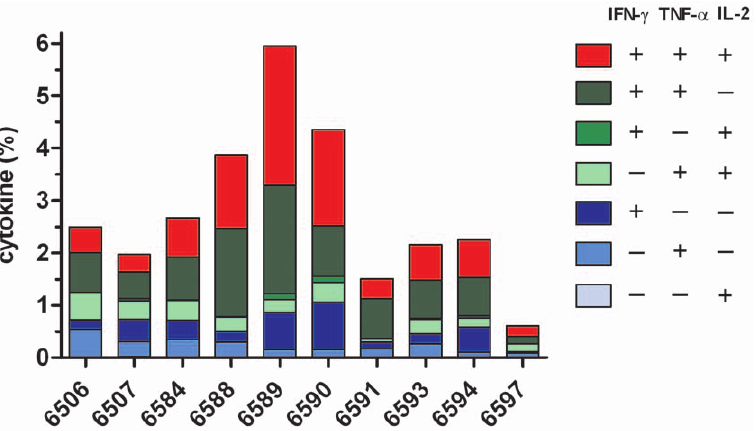
Figure 3. Characterisation of antigen-specific multifunctional CD4 + responses in cattle naturally infected with M.bovis . PBMC from naturally M. bovis infected cattle were cultured in the presence of either PPD-B or medium and the co-expression of IFN- c , IL-2 and TNF- a determined by ICS flow cytometry. The percentage of PPD-B stimulated CD4 + cells expressing all possible combinations of each the 3 cytokines is represented as a stacked bar graph for each of 10 naturally infected cattle (medium control response subtracted).